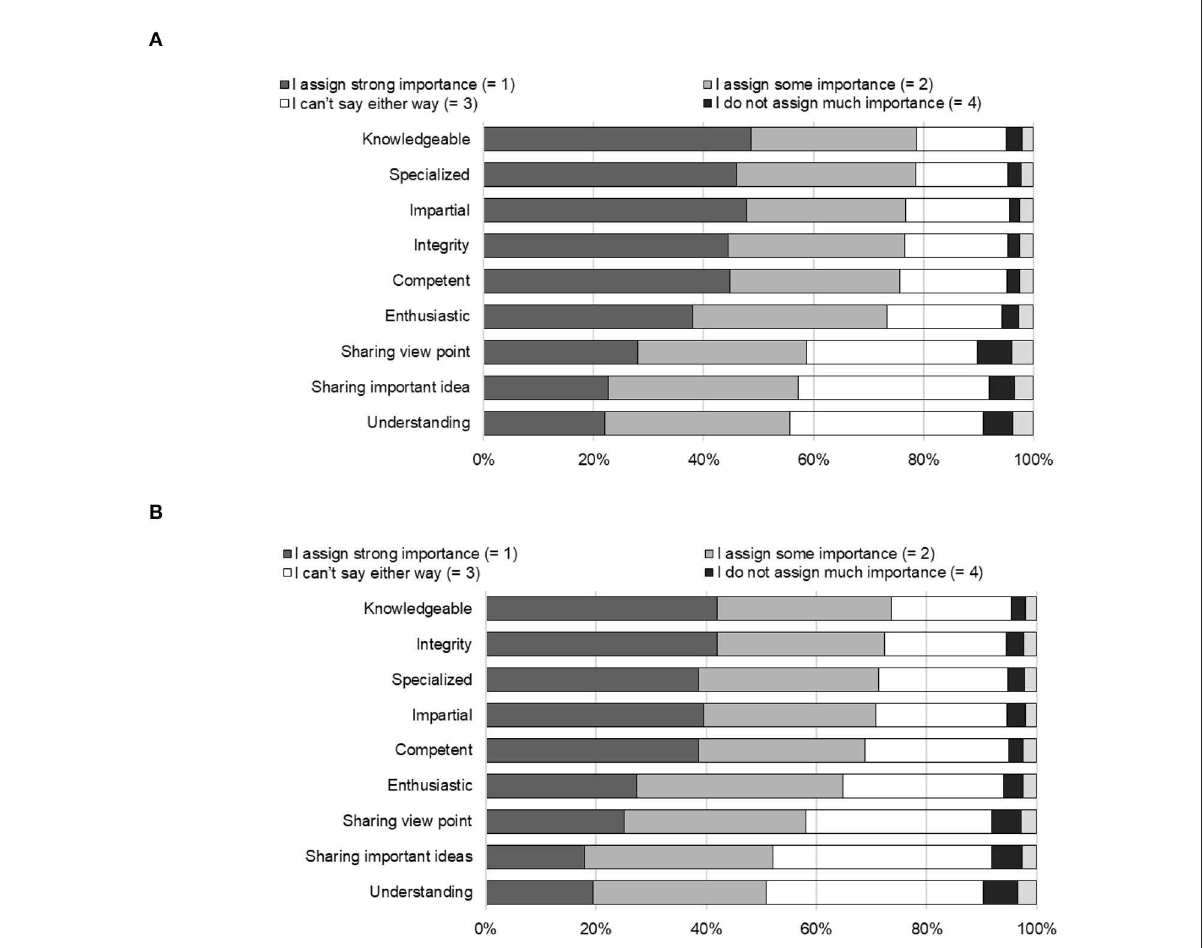
FIGURE4 Perceived importance of COVID-19 experts’ characteristics: (A) first survey; (B) second